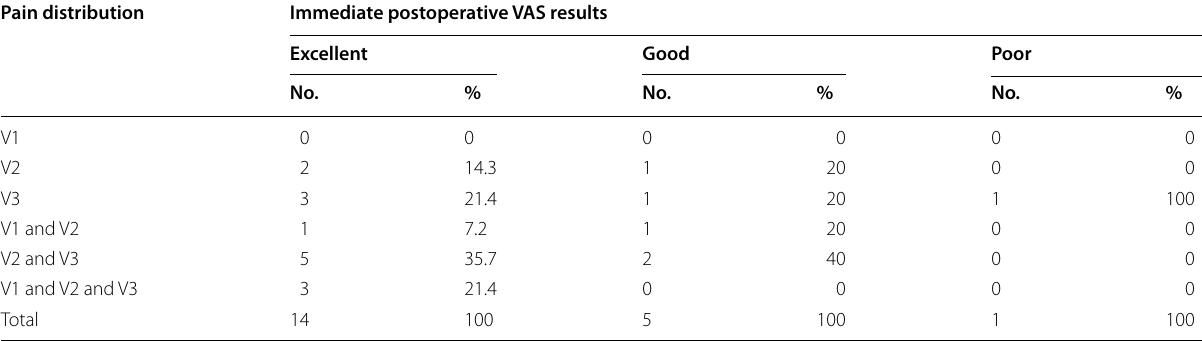
Table 5 distribution of the immediate postoperative VAS results according to pain distribution Pain